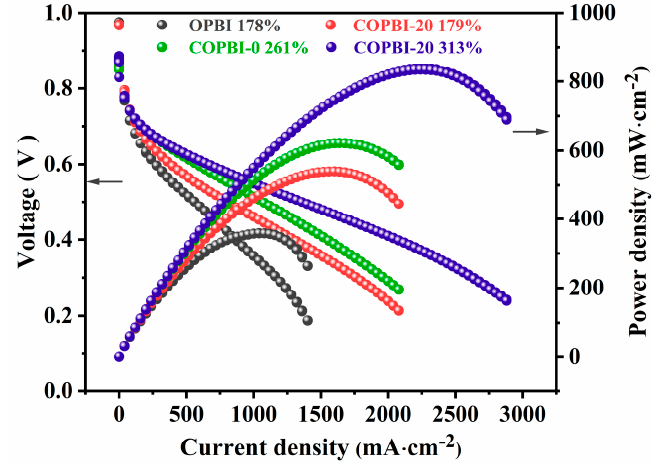
Figure 10. Single cell performance of OPBI and COPBI membranes.